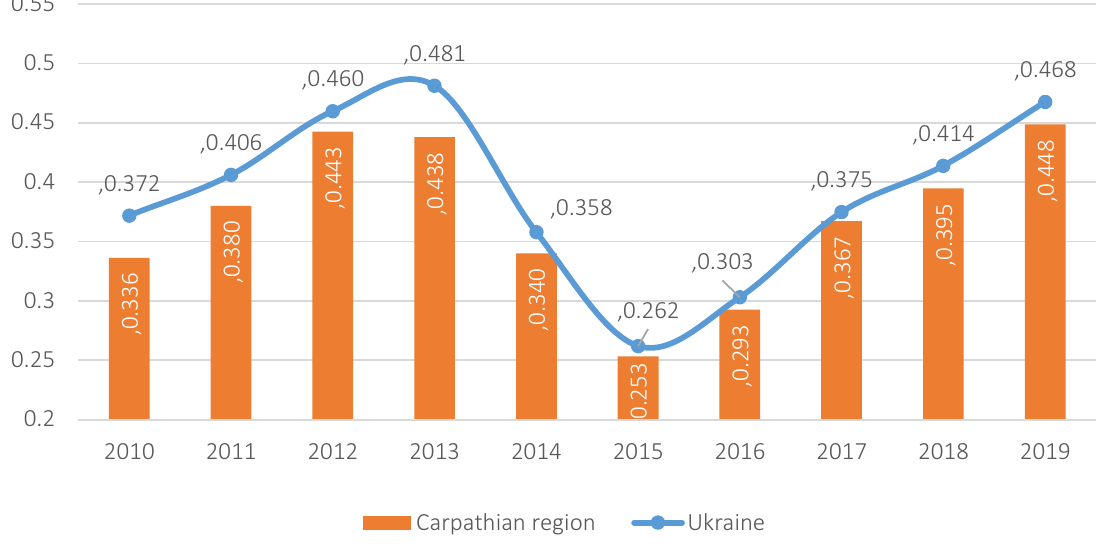
Figure 2. The divergence of the financial wellbeing of households in the Carpathian region from Ukraine,